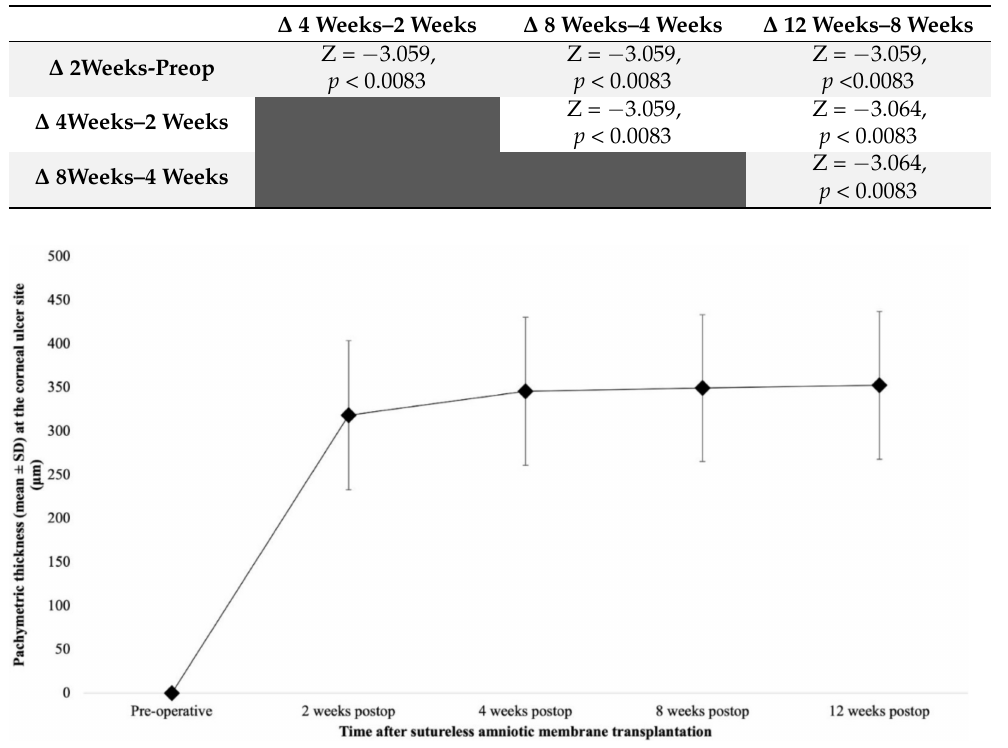
Figure 2. Graph shows the mean pachymetric variation ( µ m) and its standard deviation (SD) at the level of treated corneal